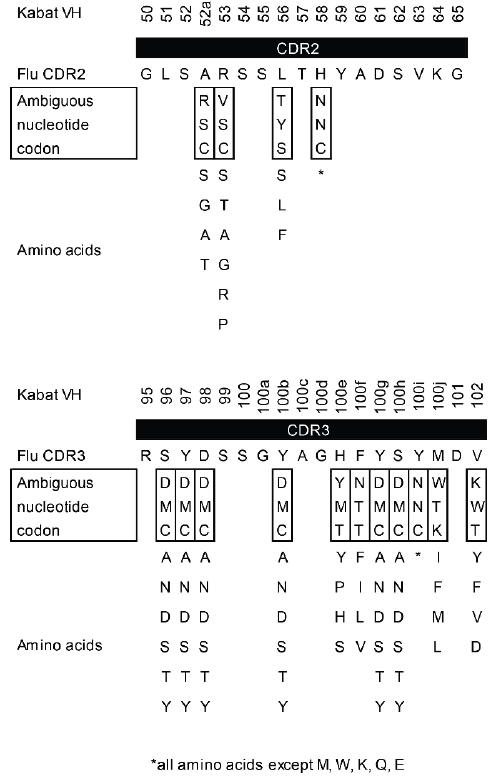
Figure 5. Design of a fluorescein-specific VHH library. CDR2 and CDR3 were randomized using PCR primers containing the indicated ambiguous codons. Nucleotide ambiguities are represented in accordance with the IUPAC code (D = A/G/T, K = G/T, M = A/C, N = A/C/G/T, R = A/G, S = G/C, V = A/C/G, W = A/T, Y = C/T). The corresponding amino acids are shown below the codons. For each position, a codon was used that provided the original amino acid along with residues according to the sequence logo and/or polar amino acids commonly found in CDR regions (tyrosine, serine). Stop codons were excluded from the library design.